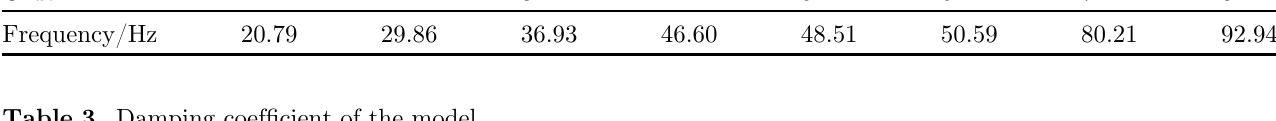
Table 2. Self-vibration frequency of SCC structure. Order